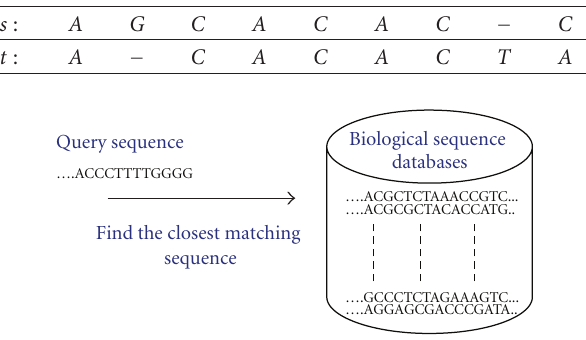
Figure 1: Pairwise sequence alignment, for example,